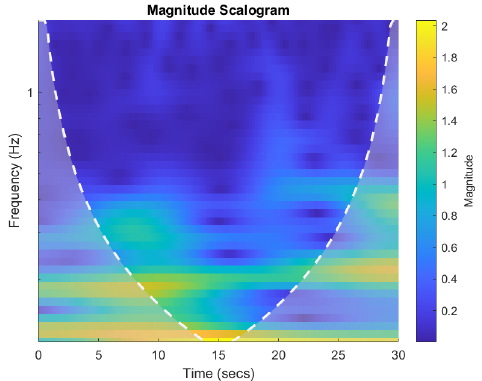
Figure 3: CWT treated conductance measurement. The same example (Figure 2) of data reported as disgust with CWT applied.